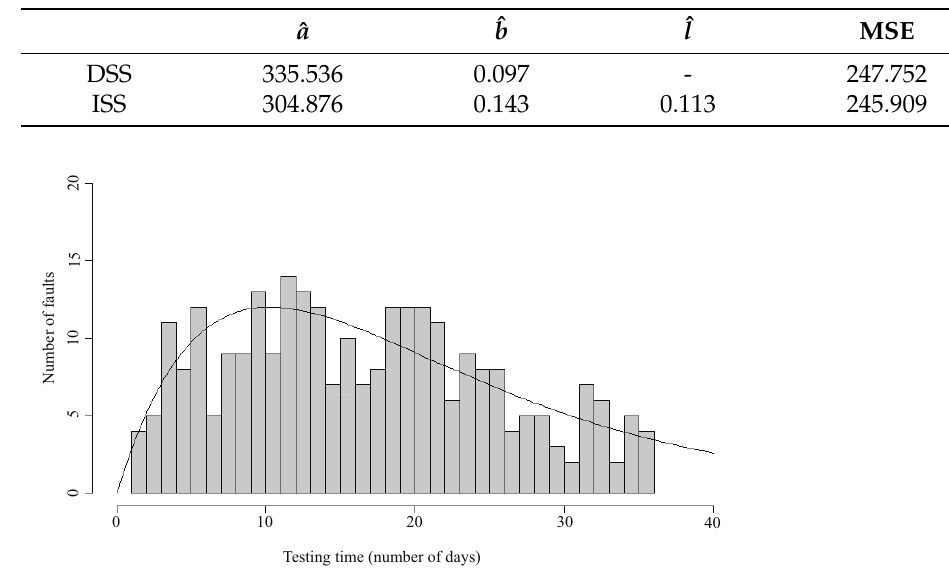
Figure 4. Generated sample data based on the intensity function of the DSS SRGM (DSS data).